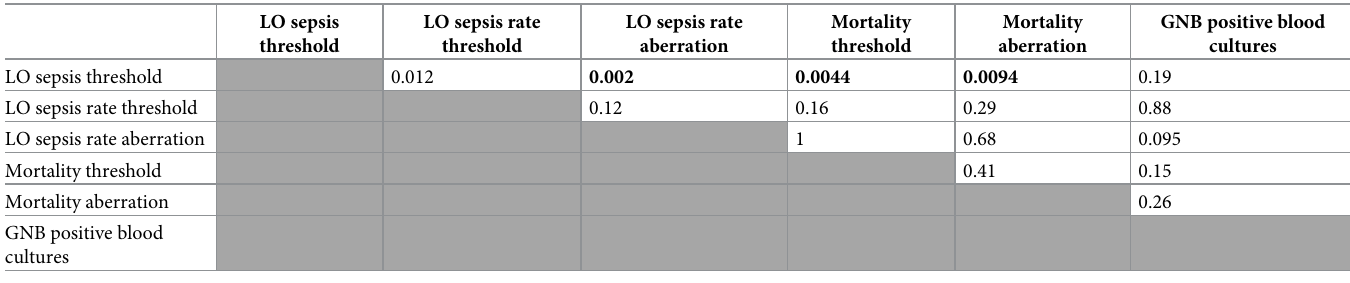
Table 6. Concordance between alarms indicators using McNemar’s